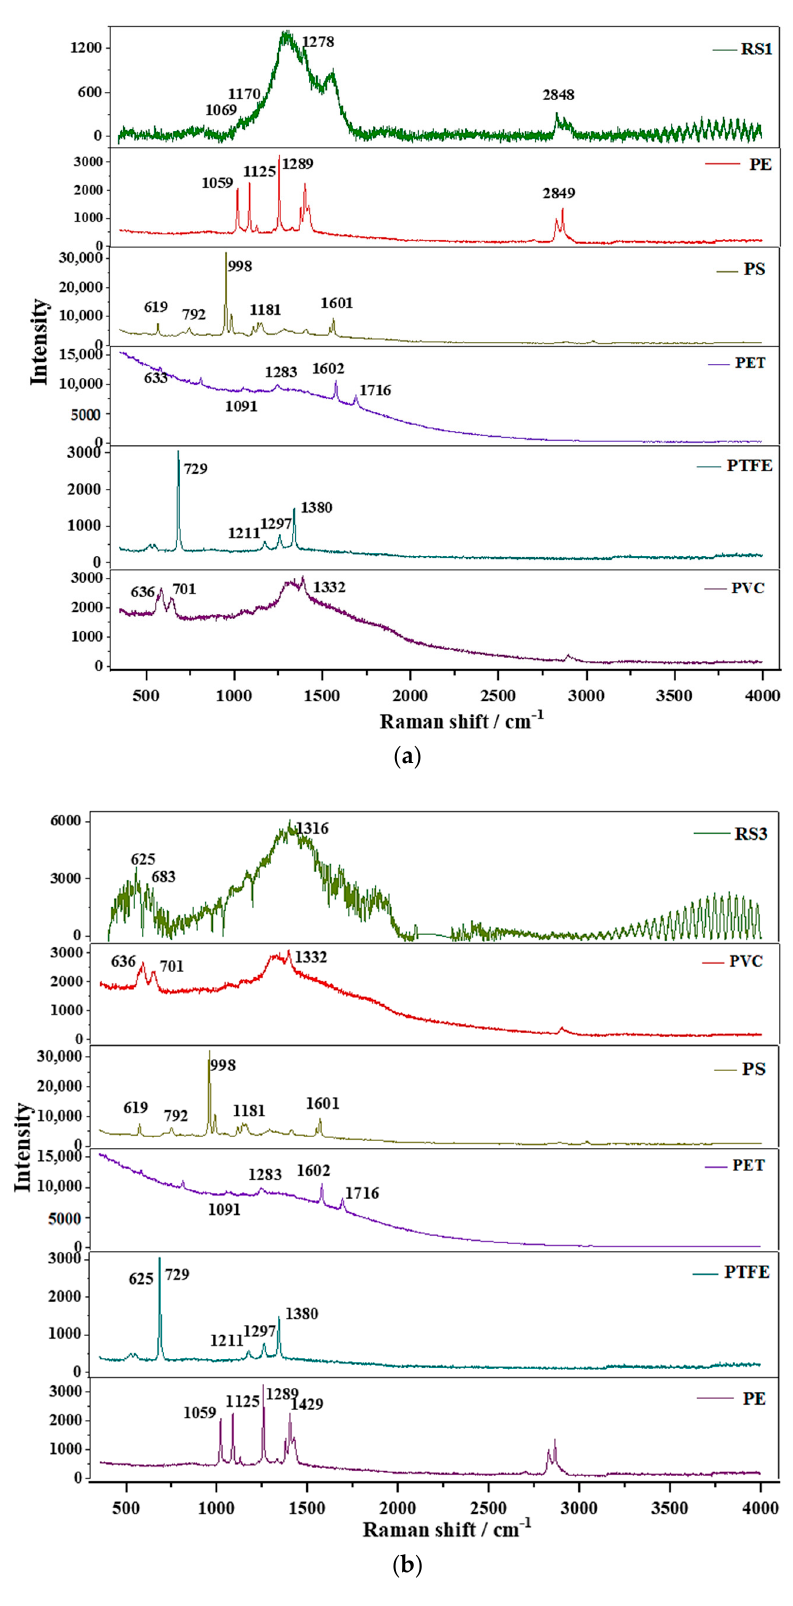
Figure 5. Identification of PF samples by Raman Spectroscopy. ( a ) Comparison diagram of RS1 Raman spectrum of sample and standard Raman spectrum of plastic; ( b ) Comparison diagram of RS3 Raman spectrum of sample and standard Raman spectrum of plastic.